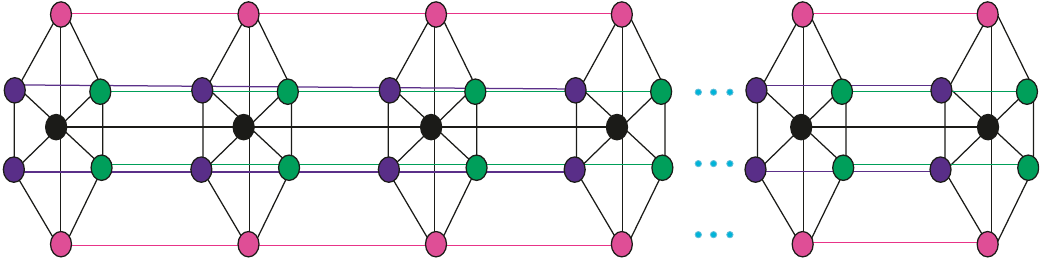
Figure 2: HEX( n ) crystal